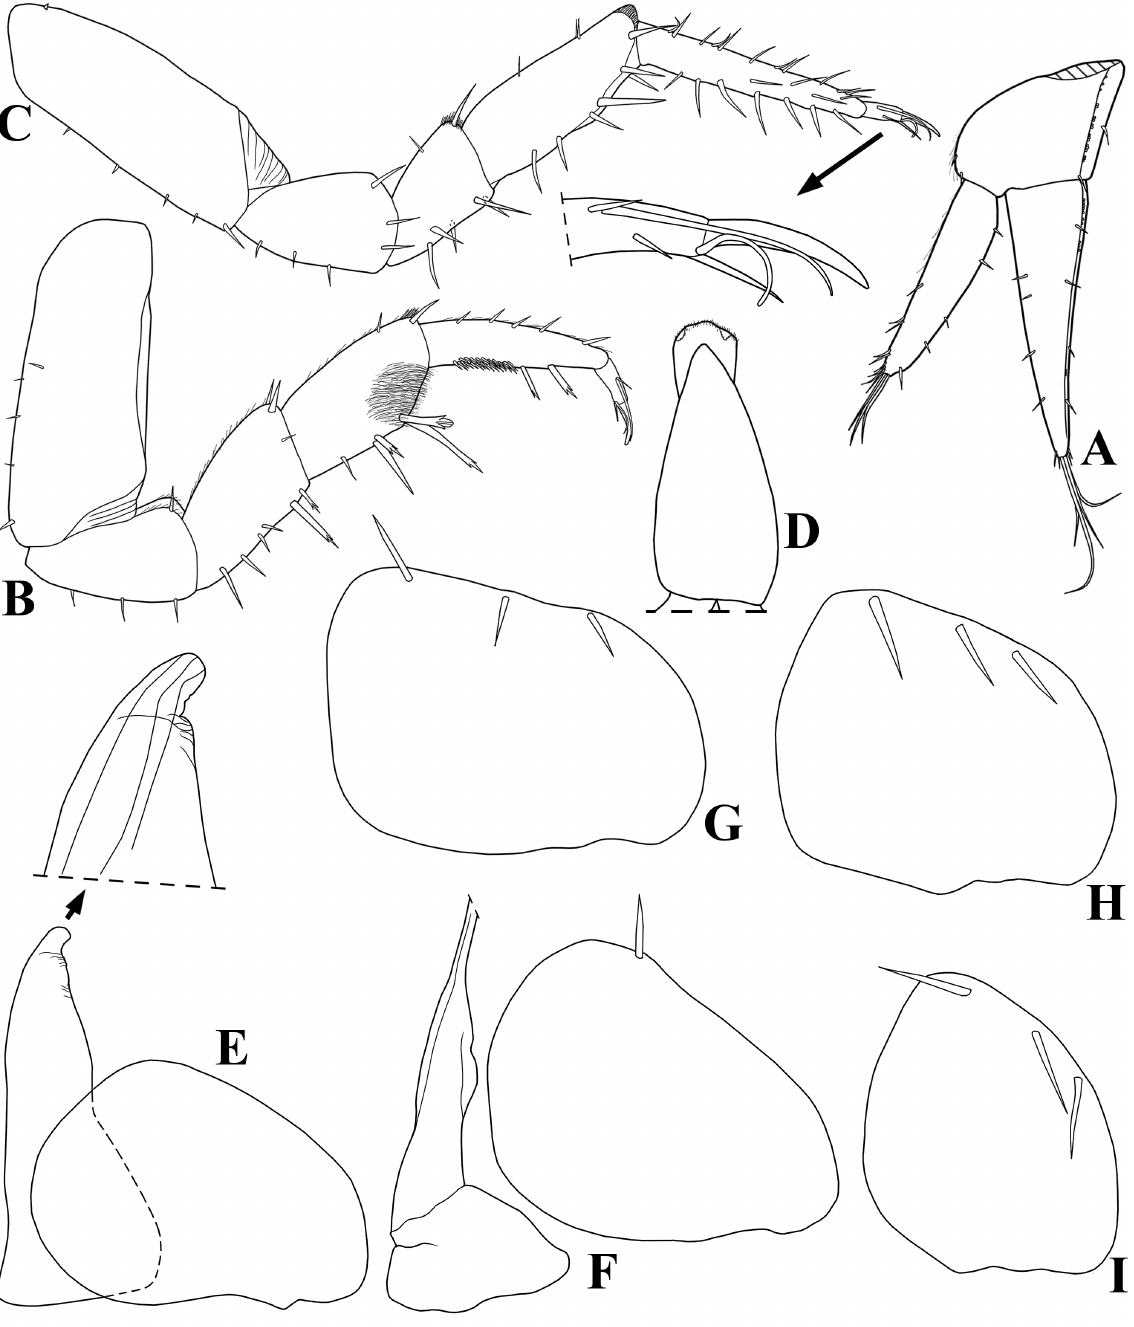
Fig. 4. Alboscia jotajota Campos-Filho, Bichuette & Taiti sp. nov., ♀, paratype (LES 18852) (A) and ♂, holotype (LES 647) (B–I). A . Uropod. B . Pereopod 1. C . Pereopod 7. D . Genital papila. E . Pleopod 1. F . Pleopod 2. G . Pleopod 3 exopod. H . Pleopod 4 exopod. I . Pleopod 5